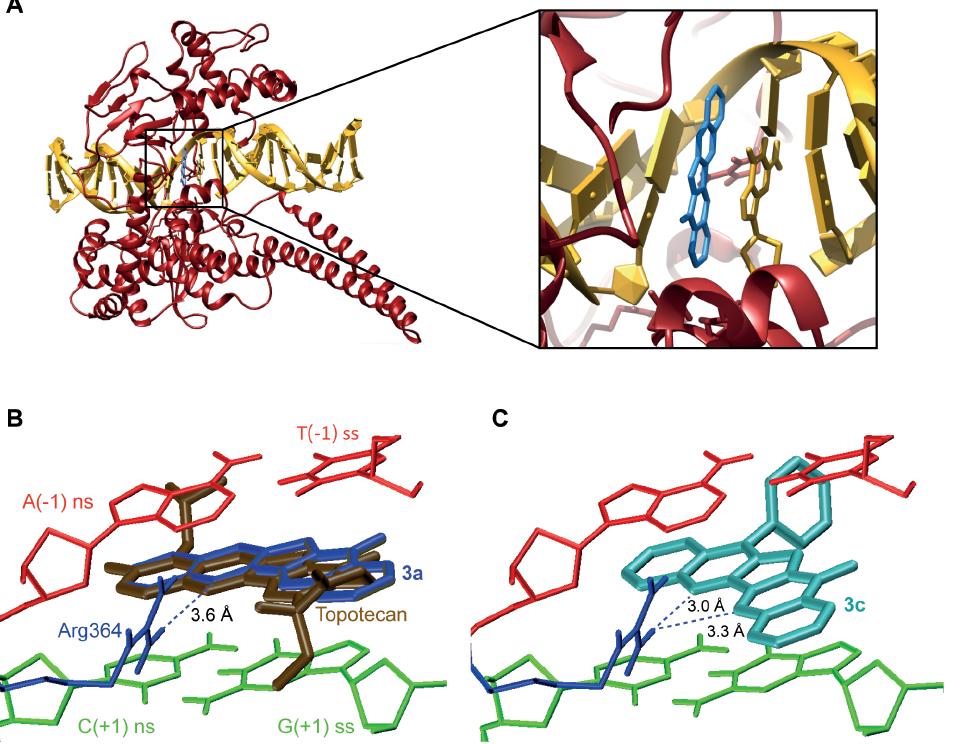
Figure 6. Docking of luotonin A, topotecan and compound 3c. A. A full view of the topoisomerase 1-DNA complex with luotonin A docked onto the active site. B. Expansion of the binding site. Luotonin A (navy blue) is shown compared with the position found for topotecan (brown) by crystallography, showing an excellent concordance between both poses. The base pairs are coloured in red ( 2 1) and green ( + 1). The topoisomerase Arg364 residue responsible for hydrogen bonding with the compounds is displayed in blue. C. Docking of compound 3c , showing the hydrogen bonding interaction of Arg364 with both nitrogens N5 and N6.